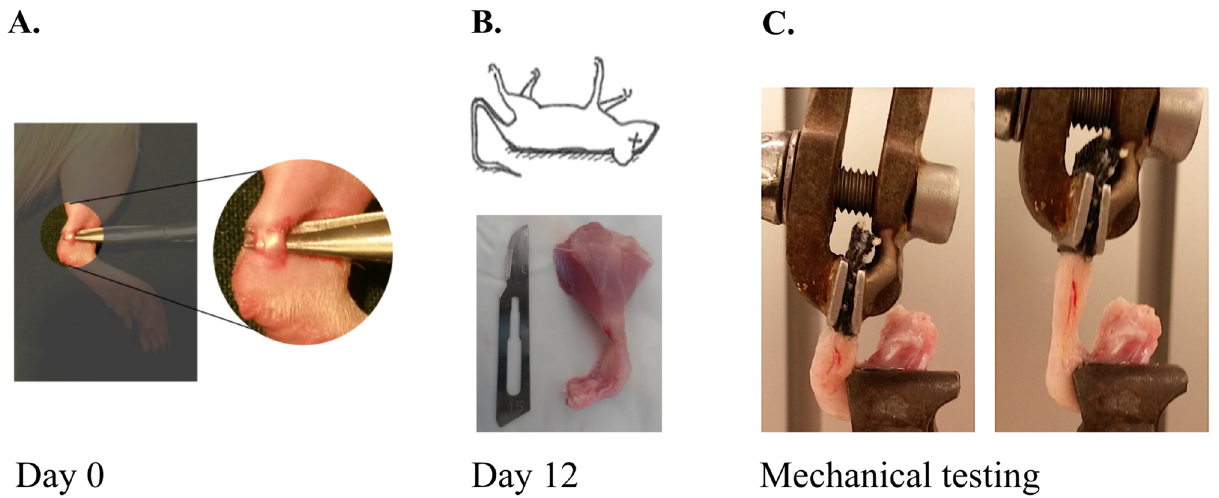
Figure 4. Experimental setup. ( A ) On day 0, a transversally skin incision was performed on the right hind limb and the tendon complex was exposed. The plantaris tendon was removed and the Achilles tendon